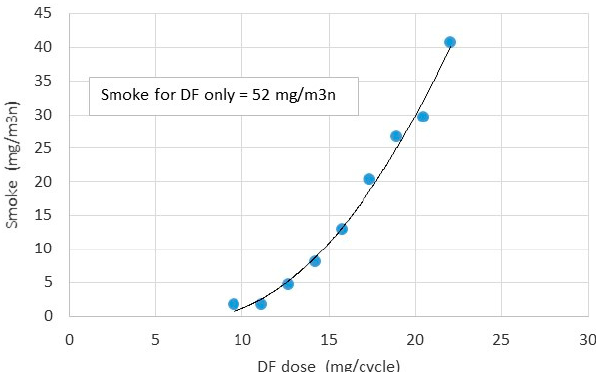
Figure 11. Smoke vs. glycerol-ethanol ( G + E ) dose.